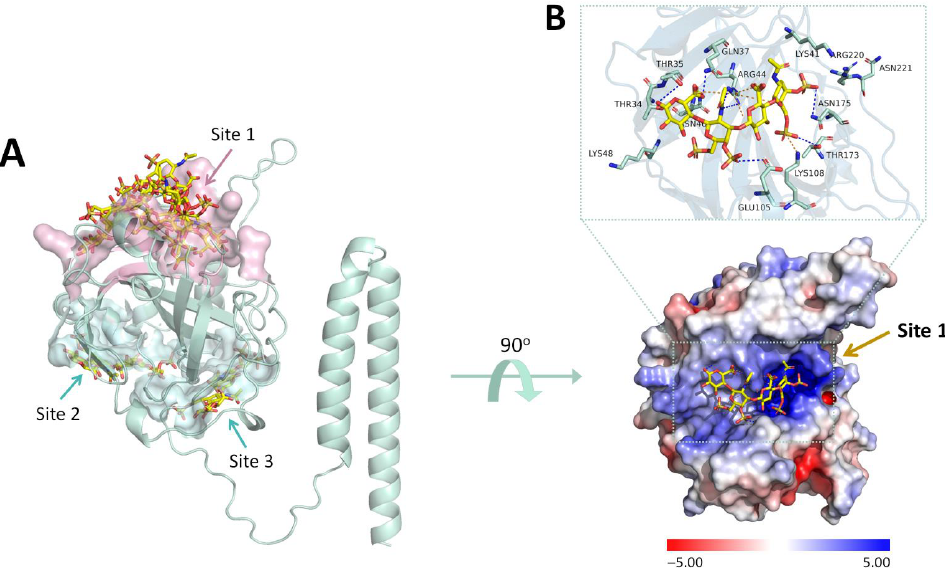
Figure 3. The binding pocket of chondroitin sulfate-E on the MPXV E8 protein: ( A ) The blind docking approach revealed three appropriate binding sites for CS-E, in which seven out of nine ligand conformations were found at Site 1 of the protein (pink). ( B ) The protein surface represents the electrostatic status of the MPXV E8 protein and the binding mode of CS-E in binding site 1. The hydrogen bonds are shown as blue dashes and the salt bridges are shown as orange dashes.